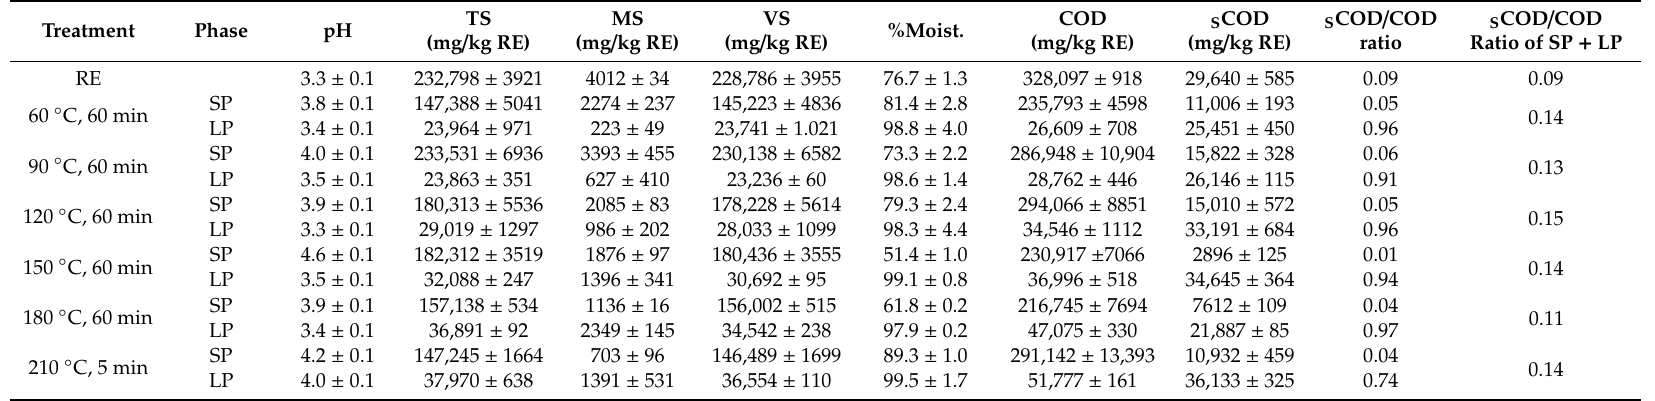
Table 2. Physicochemical characterization of untreated raspberry extrudate and di ff erent solid and liquid phases obtained by centrifugation after all hydrothermal treatments were carried out: untreated raspberry extrudate (RE), solid phase (SP), liquid phase (LP), chemical oxygen demand (COD), soluble COD (sCOD), total solids (TS), mineral solids (MS), volatile solids (VS) and moisture